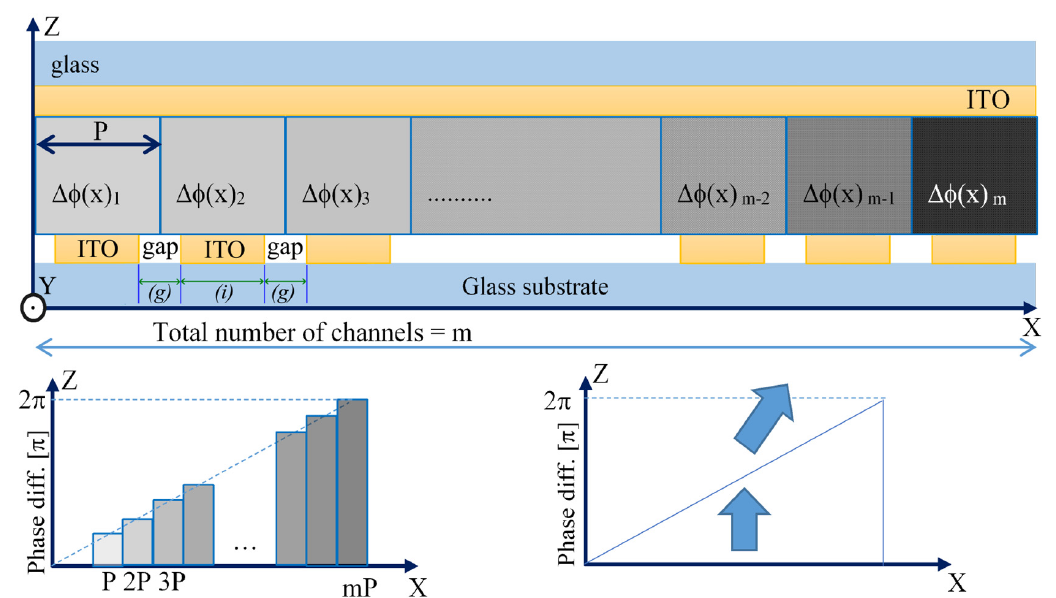
Figure 1. LC ‐ based BD cell geometry and concept. The fill factor (FF) of the grating is the ratio of the ITO electrode width ( i ) to the gap ( g ) on the lower substrate. In this example, FF = i/g = 1.5/0.5 μ m. The full period ( p ) of the grating in the example shown is 2 μ m.